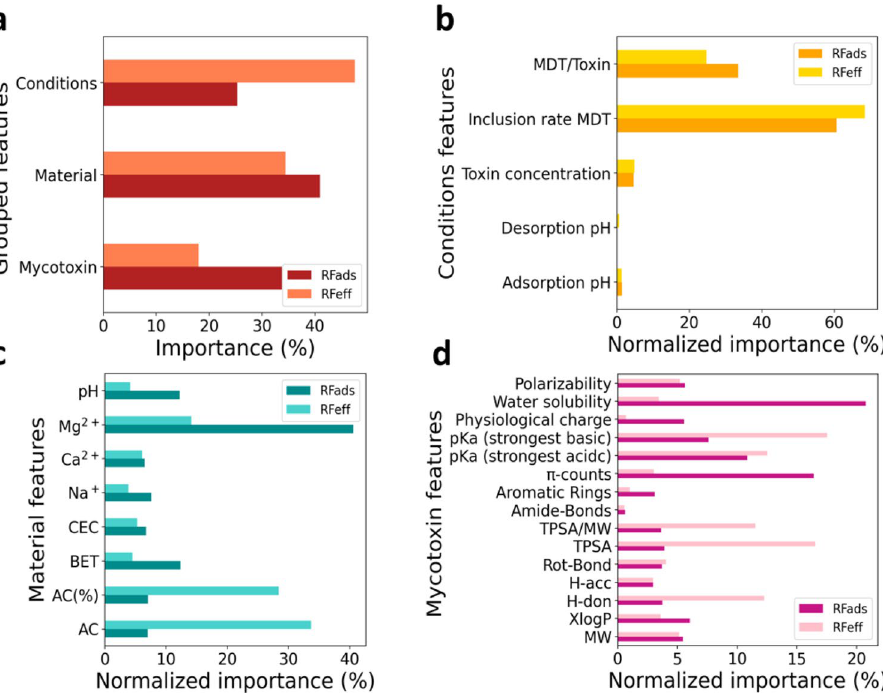
Figure 3. Summed importance score of the groups of features outlined in Table 2, extracted by RFads and RFeff ( a ). Normalized individual contribution corresponding to in vitro experimental conditions ( b ) materials ( c ) and mycotoxin ( d ) group of